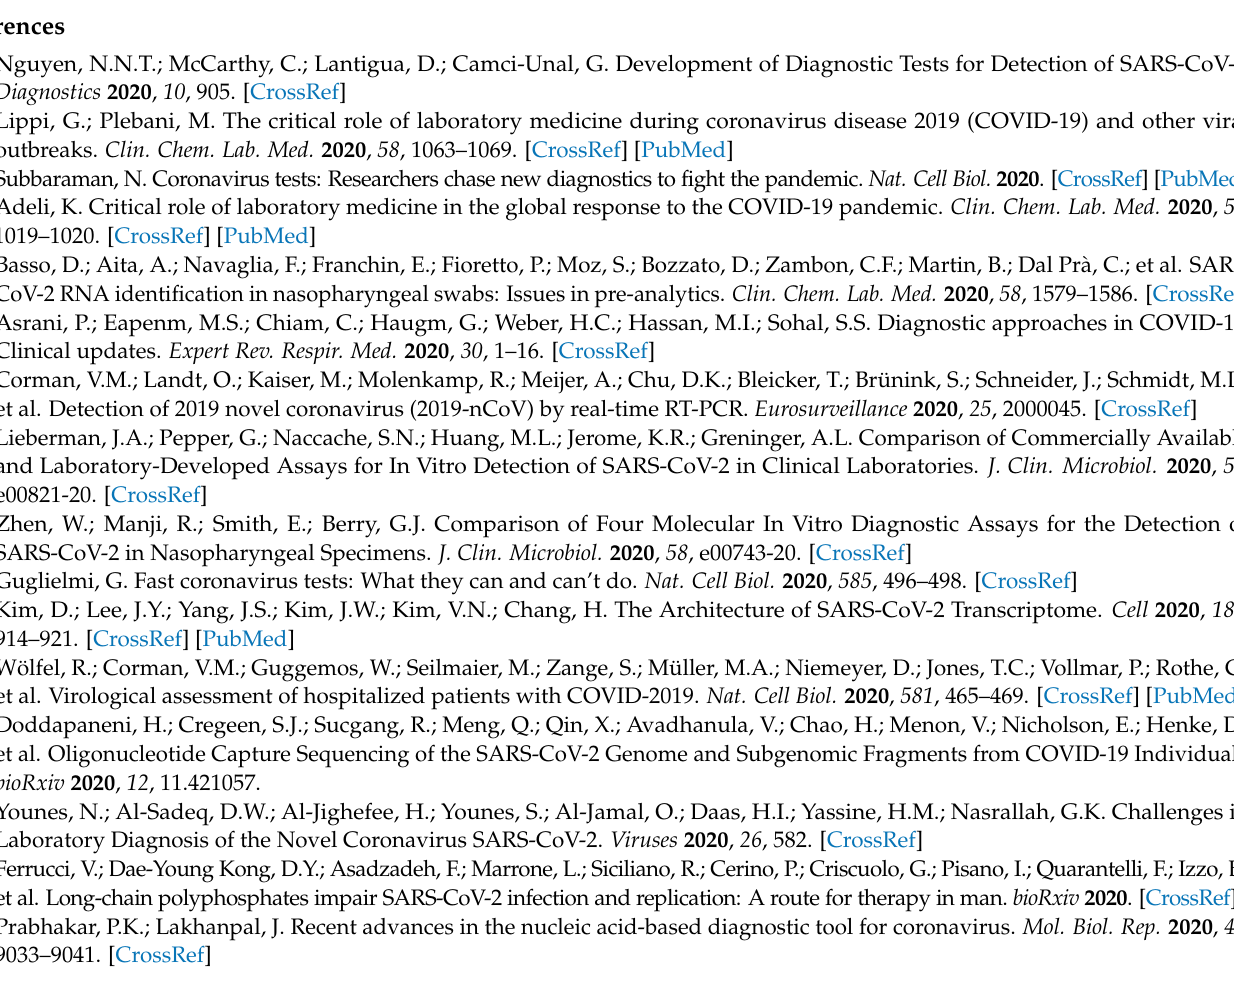
Figure S3: Sanger sequencing of the N subgenomic region of